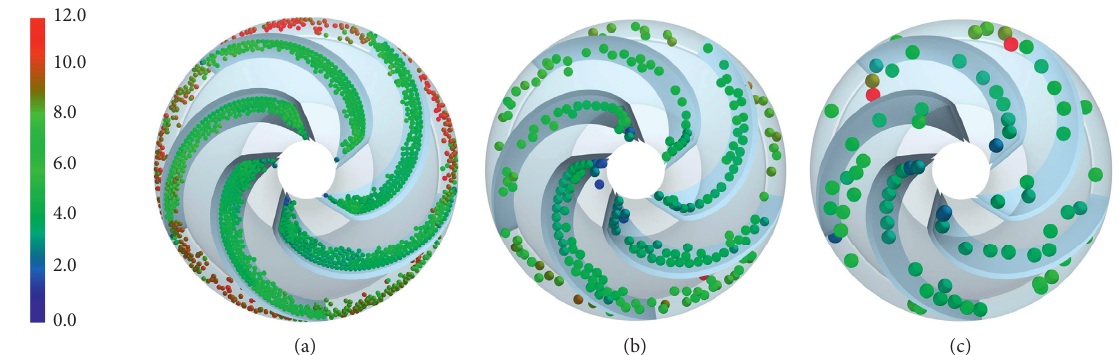
Figure 9: Particle distribution in guide vane region: (a) 5 mm, (b) 10mm, and (c) 15mm.